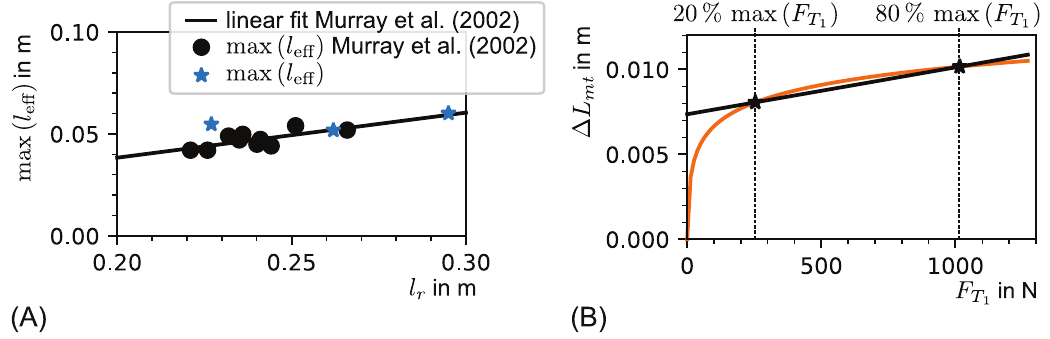
Fig 14. (A) Validation of the maximal effective lever length. The maximal effective lever length l eff over the radius length is shown as black dots, as presented in the cadaver study by Murray et al. [42]. The linear fit of Murray’s data is shown as black line. The blue stars are the maximal effective lever lengths of the subjects in this study. A complete course of the effective lever length is shown in Fig 10B for subject 0. (B) Non linear and linear prediction of myotendinous junction movement. The non linear prediction of the myotendinous junction movement over tendon force is shown in orange. The prediction is based on Eq (10). As parameter set, the resulting fit on (semi-) automatically extracted data from all angels Θ � 75 � of subject 0 was used. In addition, a linear model is shown in black. This linear model was parameterized such that the linear function includes the predicted values for 20% and 80% of the maximal tendon force generated during voluntary contraction ð max ð F Þ ¼ 1270 N Þ . The stiffness of the T 1 depicted linear model was c lin,20-80 =